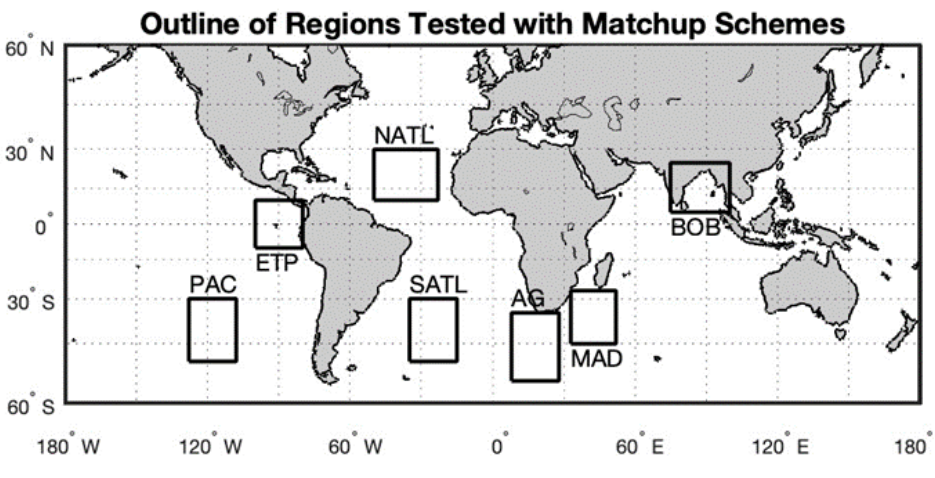
Figure 1. Outlines of the regions being tested.